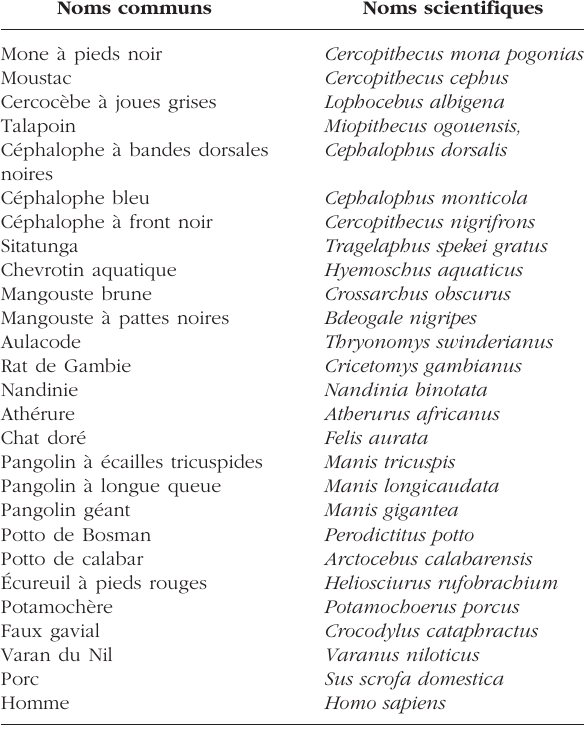
Tableau I. – Noms communs et scientifiques des vertébrés consti- tuant les échantillons de faune pour l’étude de l’origine des repas de sang des